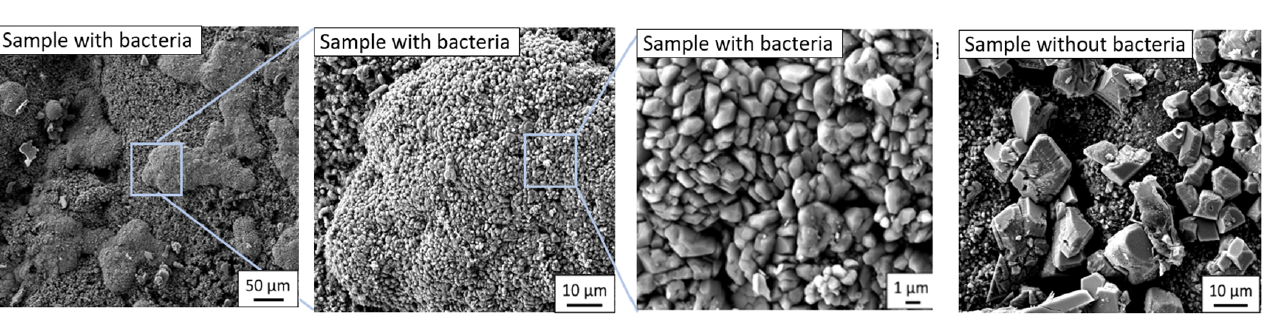
Figure 1. Optical images of the crack healing process over 56 days: 1—Crystals clusters (last image magnified to 80×).